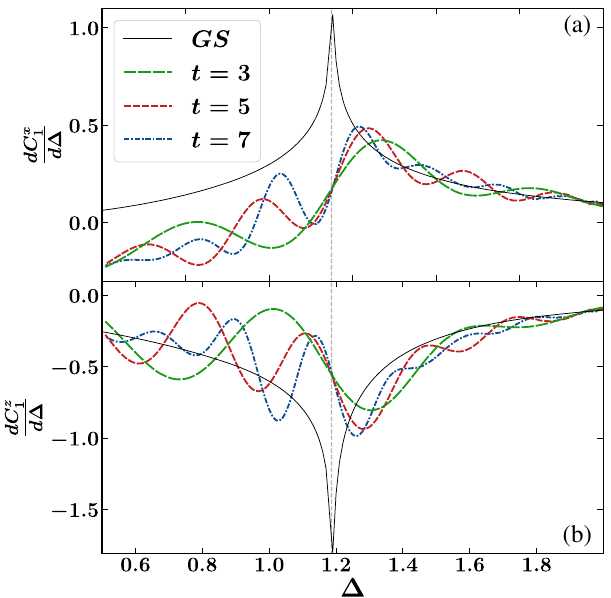
FIG. 12. Signatures of the N´eel to Haldane quantum phase transition in the anisotropic XXZ chain. Derivatives with respect to Δ of (a) C x 1 [see Eq. (3)] and (b) C z 1 [see Eq. (14)] at different fixed times after the quench and of the results in the ground state (black solid line). The gray vertical line shows the critical Δ ≈ 1 . 183 c